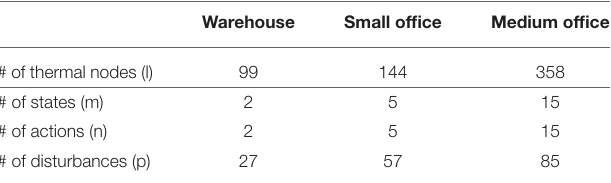
TABLE 1 | Dimensions of the state space models of the warehouse , the small office , and the medium office ; Only the zone temperatures, i.e., the states, are observable, while the temperature at the other thermal nodes are